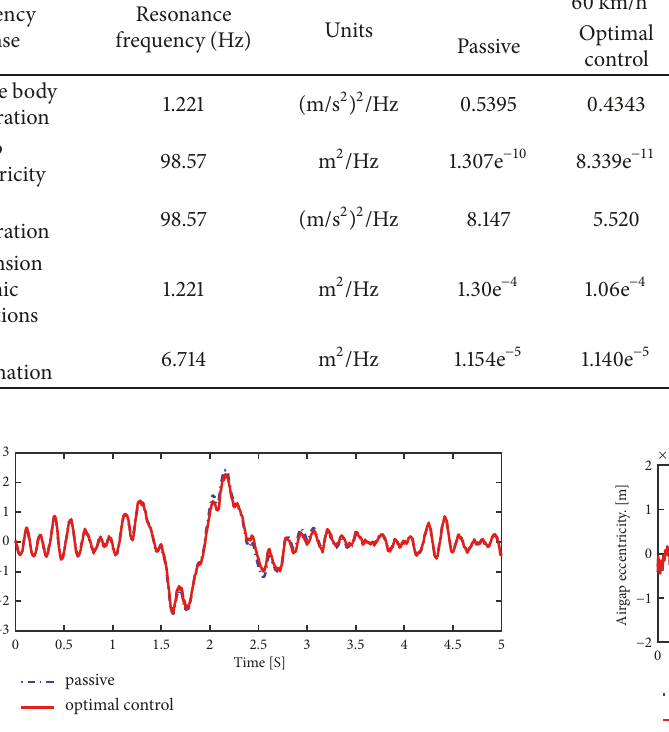
Figure 17: Time history response of vehicle body acceleration.